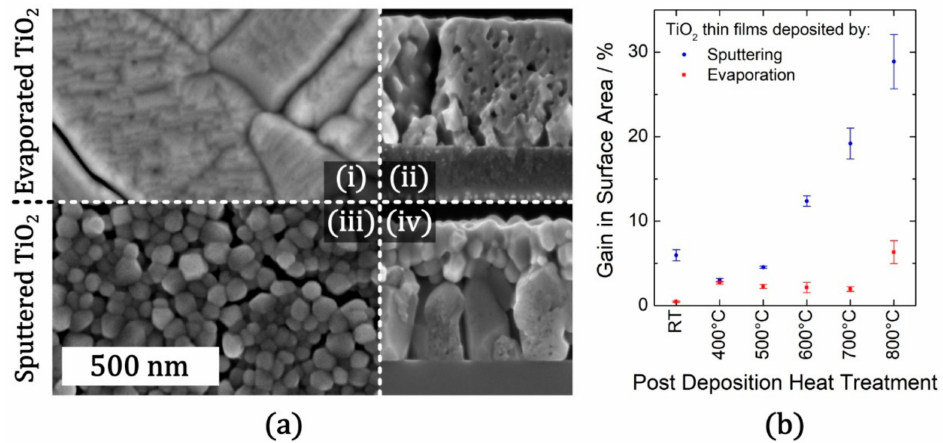
Figure 1. ( a ) SEM micrographs (having same scale bar of 500 nm) in top view ((i) + (iii)) and cross section ((ii) + (iv)) configuration of TiO 2 thin films post heat treatment (800 ◦ C 1 h): (i) + (ii) evaporated TiO 2 ; (iii) + (iv) sputtered TiO 2 . ( b ) Gain in surface area for sputter deposited or evaporated TiO 2 thin films compared to an ideally flat thin film, calculated from atomic force microscopy (AFM) measurements (thin films have no open porosity). The error bars correspond to three standard deviations (3 σ ). Adapted with permission from [10]. Copyright (2016)